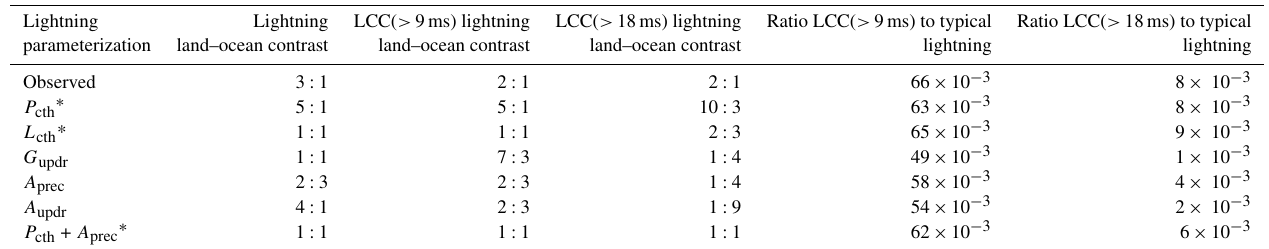
Table 2. Contrast between land and ocean for LCC( > 9ms), LCC( > 18ms), and total lightning flashes for each lightning parameterization. We add the symbol ∗ to the lightning parameterizations that are different for land and